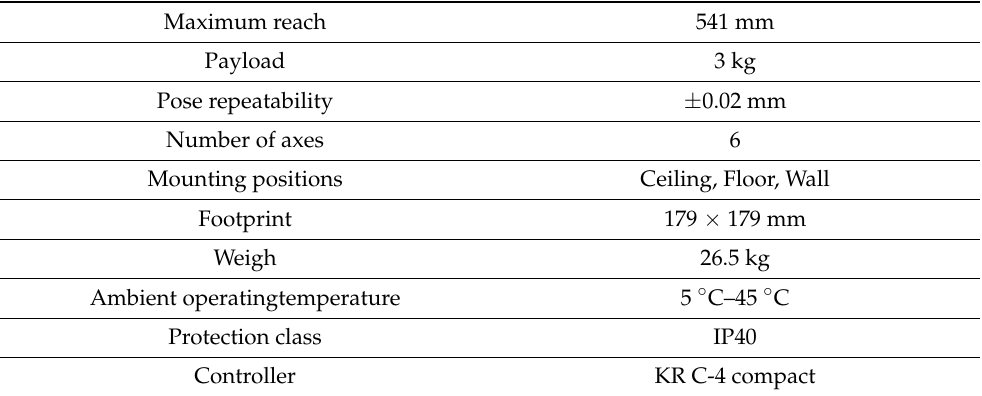
Table 1. Table 1. KUKA KR3 R540 parameter